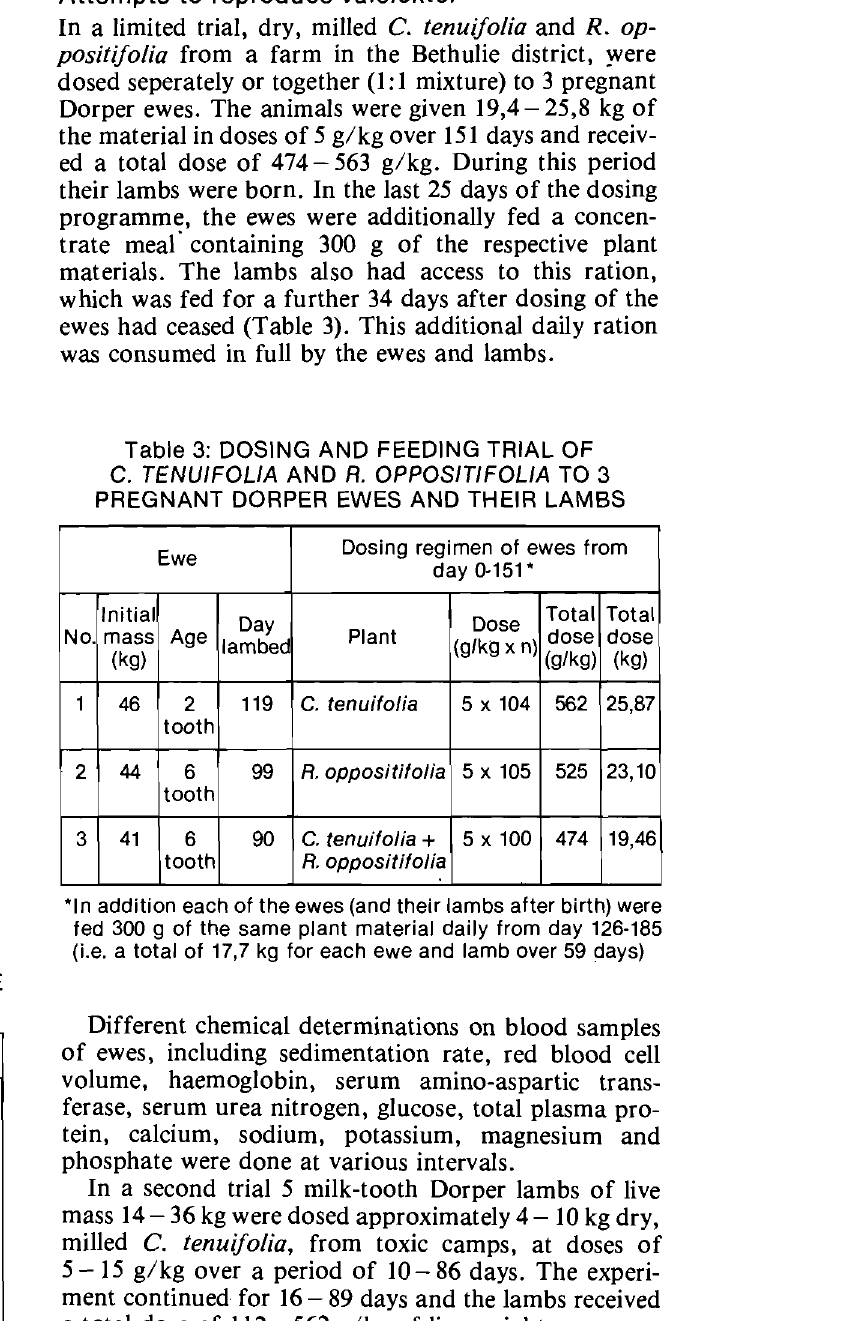
Table 1: THE LIVER AND KIDNEY COPPER LEVELS (p.p.m.) ON A WET BASIS, OF AFFECTED FIELD·CASE LAMBS